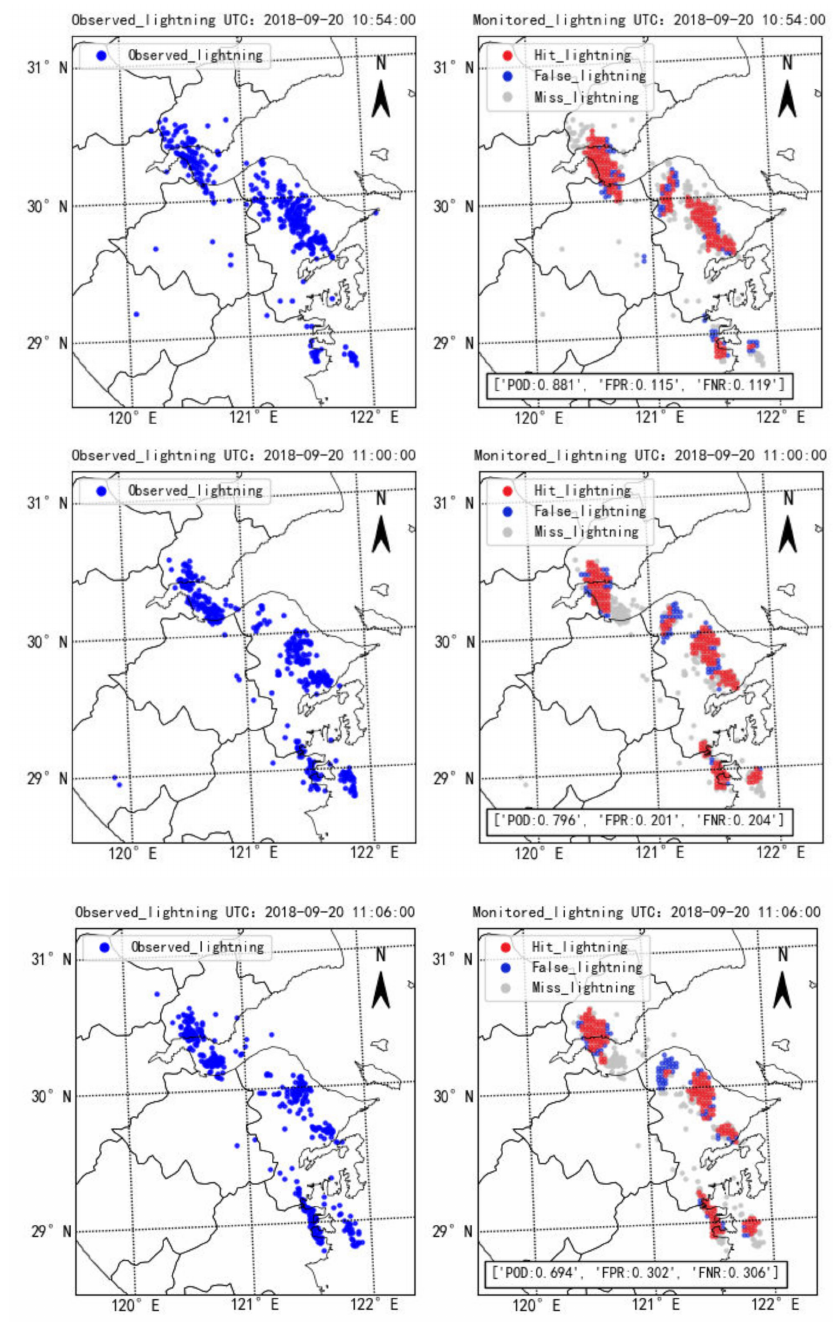
Figure 6. Results of observations of lightning data and model monitoring